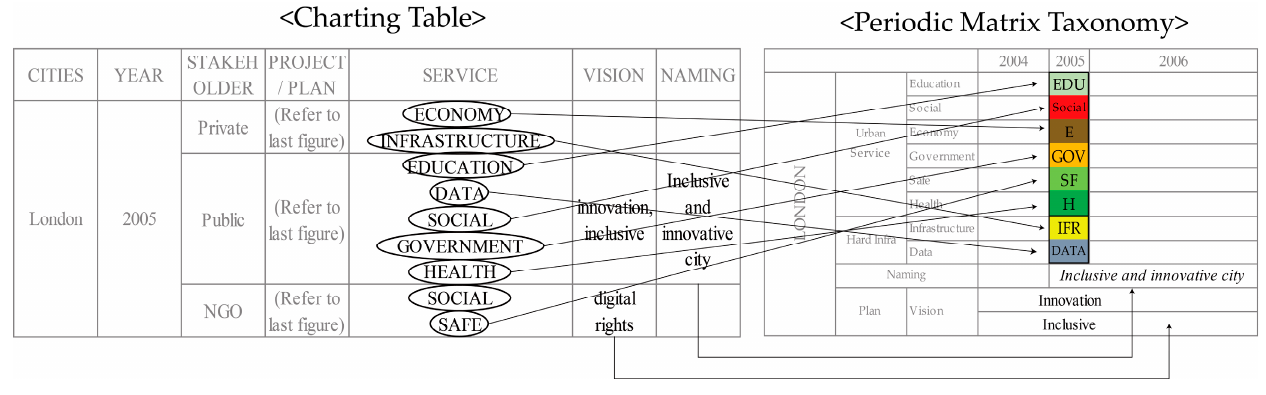
Figure 5. Coding Data.